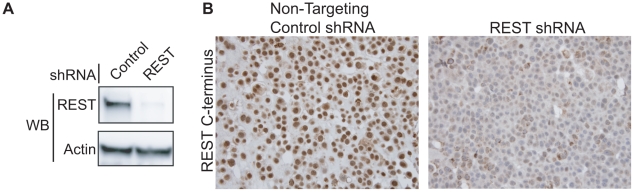
Testing the specificity of the REST C-terminal antibody.(A) MCF7 breast cancer cells were infected with lentivirus bearing either non-targeting control shRNA or REST targeting shRNA. REST knockdown was verified by western blot (Millipore antibody). Beta actin expression in shown as a loading control. (B) Paraffin-embedded MCF7 sections were stained with antibody to the REST C-terminus (Sigma) (stained brown), with hemetoxylin nuclear stain (stained blue). Control shRNA expressing cells show strong nuclear REST staining, while REST shRNA expressing cells show little to no nuclear REST staining.